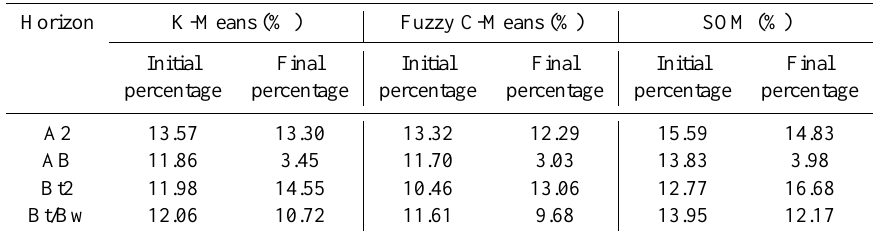
Table 5. Porosity percentages for FFNN classifications.